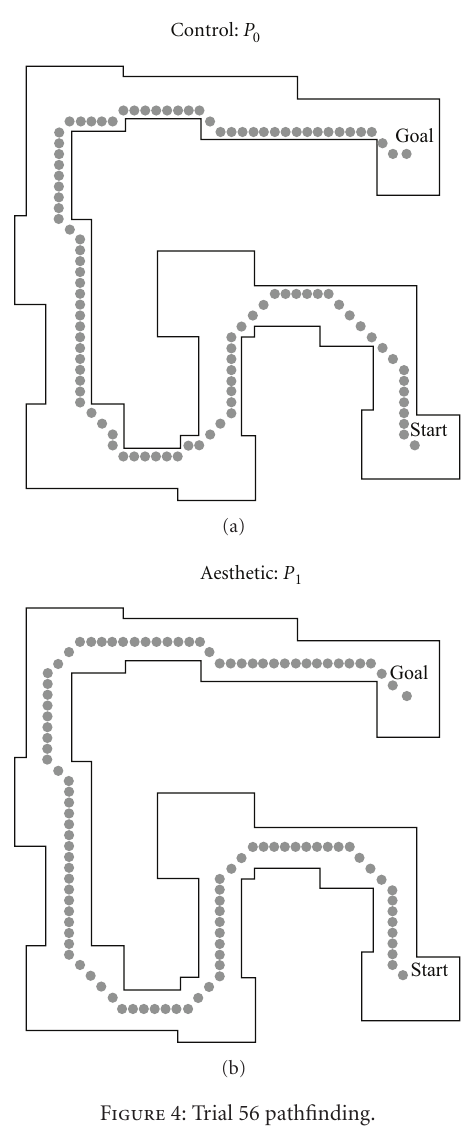
Figure 4: Trial 56 pathfinding.